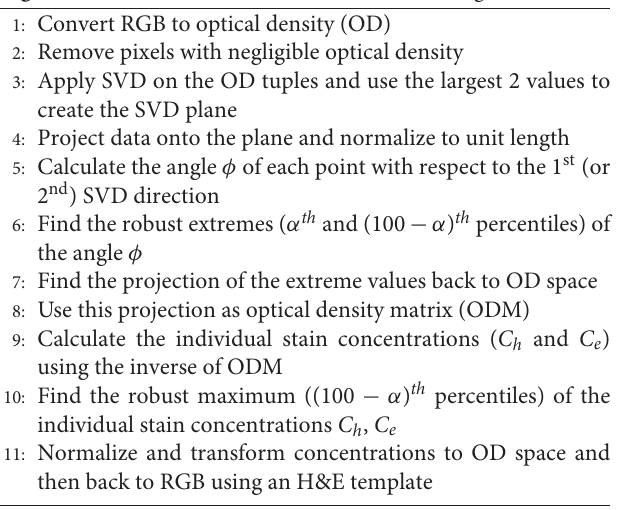
Algorithm 1. Most of the processing steps are applied to the RGB color vectors converted to optical density (OD) domain. Each RGB vector I with the color components normalized to [0,1] is transformed as follows OD = − log 10 ( I ). This transformation provides a space where a linear combination of stains results in a linear combination of OD values. Algorithm 1: The Macenko stain normalization